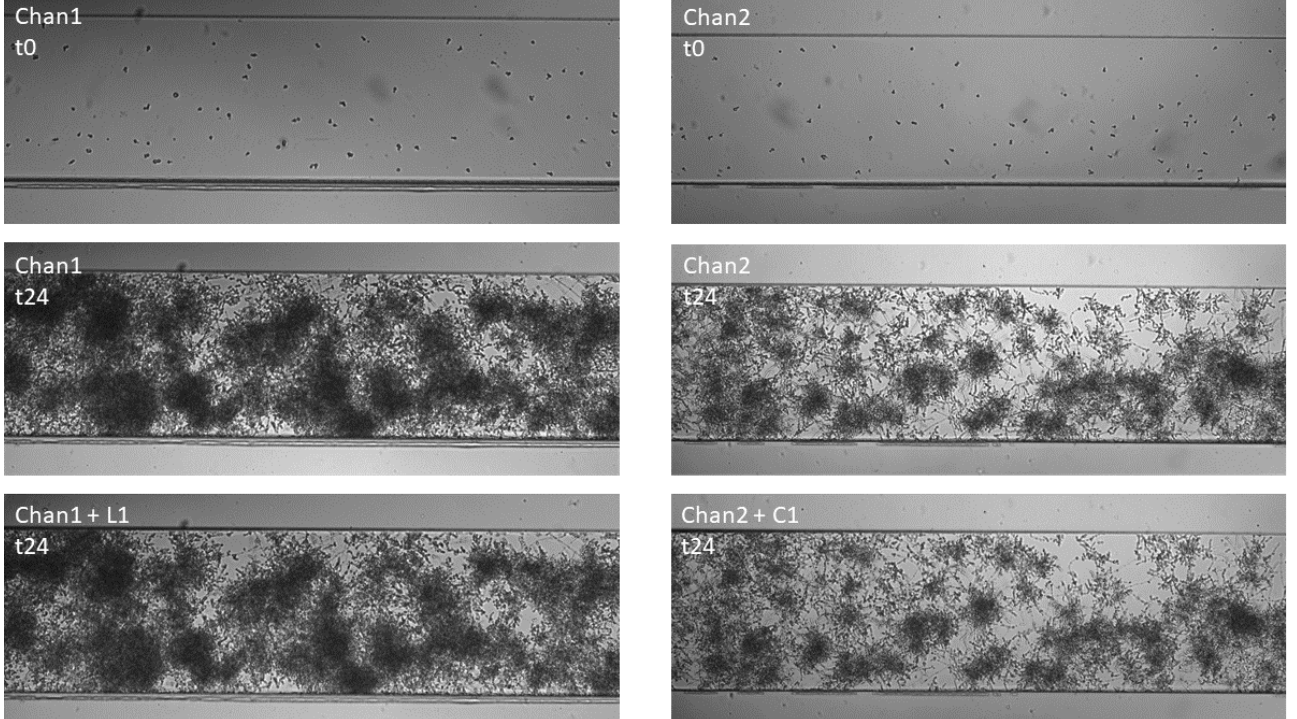
Figure 7. C. albicans CA1 biofilm formation and eradication, incubated in RPMI1640 medium under microfluidic conditions, in two separate channels (Chan1 and Chan2) of the BioFlux Z1000 system. t0—start of experiments, CA1 blastospores; t24—formed 24-h mature CA1 biofilm; L1/C1 t24—24-h eradication of CA1 biofilm with lipopeptides L1 or C1, respectively.